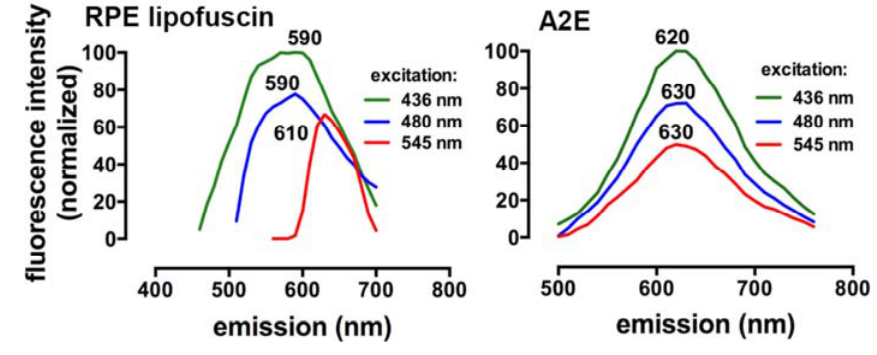
Figure 3. Fluorescence emission spectra of human RPE lipofuscin and A2E (in PBS with 2% DMSO). Emission was recorded at excitation wavelengths 436, 480 and 545 nm as published [49]. Emission maxima are